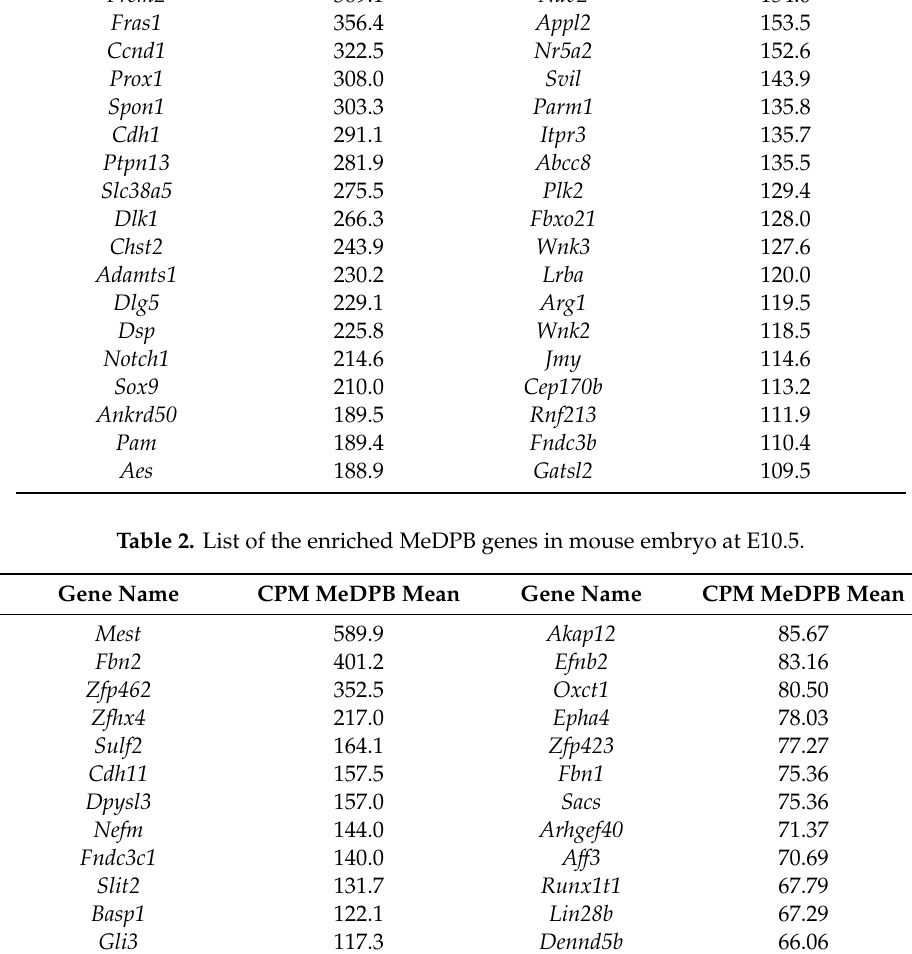
genes. Each dot on the plot is a single gene feature. Horizontal axis: fold change (in log2 scale); vertical axis: FDR-corrected p-value (in log10 scale). Color coding is based on the fold change. Thick vertical lines highlight fold changes of − 2 and + 2, while a thick horizontal line represents a p -value of 0.05. ( C ) PCA plot. Samples were represented in three-dimensional PCA plot. ( D ) Flowchart adopted to identify enriched genes in DPB (left panel) and MeDPB (right panel). According to RNA-seq analysis